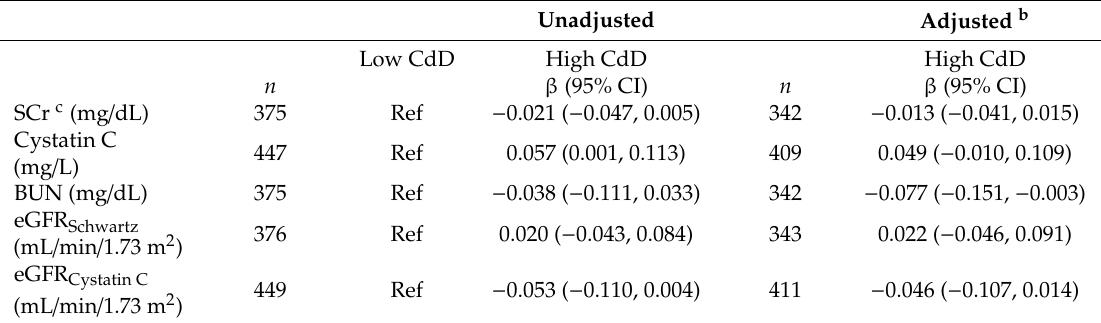
(Table 3), we observed an inverse association between dietary Cd and BUN ( β = − 0.077 (95% CI: [ − 0.151, − 0.003])) and, marginally, with eGFR CystatinC ( β = − 0.046 (95% CI: [ − 0.107, 0.014])). Table 3. Association between tolerable weekly intake (TWI) a dietary cadmium exposure at 9 years and concurrent kidney function parameters in children.